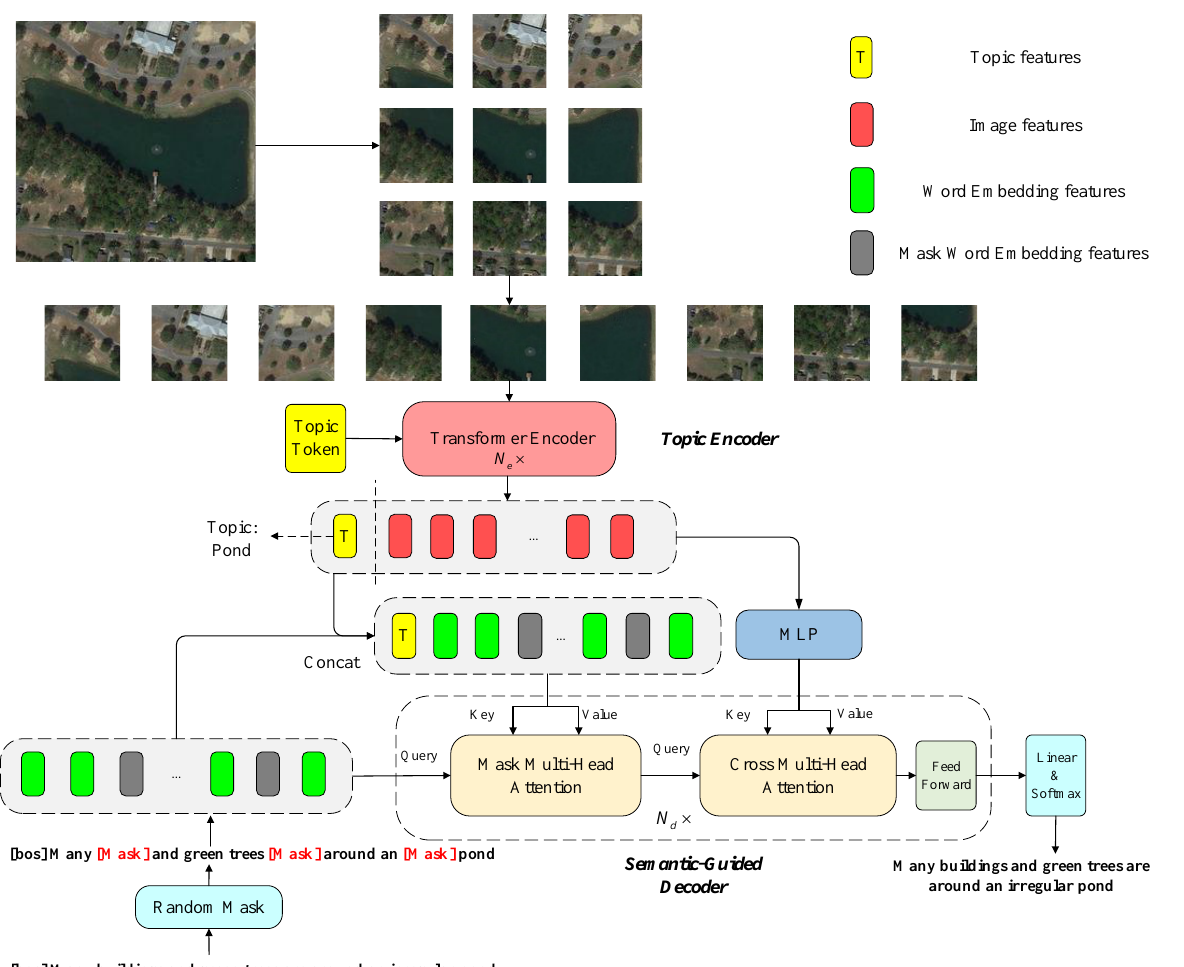
Figure 2. The structure of proposed mask-guided Transformer with topic token. For the sake of clarity, the AddNorm and embedding operations are not